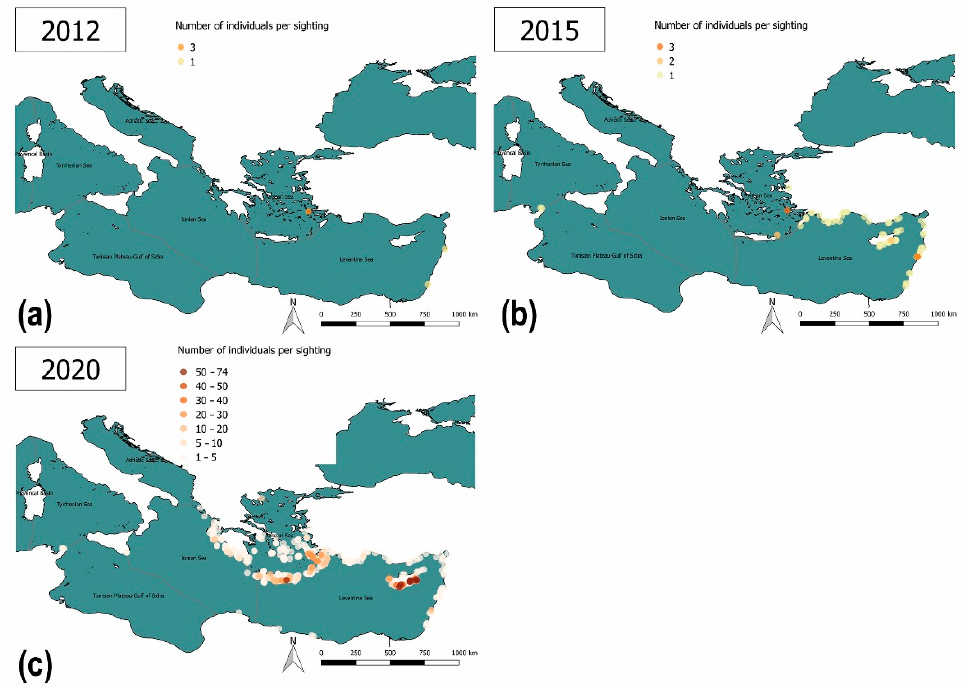
Figure 3. Number of individuals observed per sighting for ( a ) 2012, ( b ) 2015, and ( c ) 2015. The dataset is available in Supplementary Material